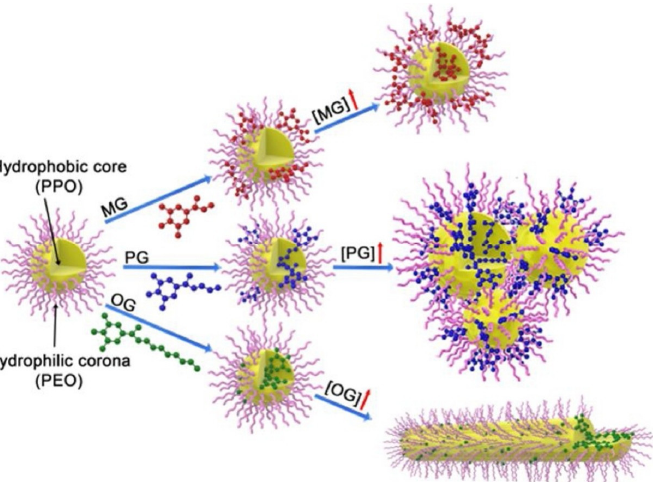
Figure 4. Impact of different gallate derivatives on the morphology of Pluronic P123 micelle. Reprinted from [51], Copyright 2019, with permission from Elsevier.